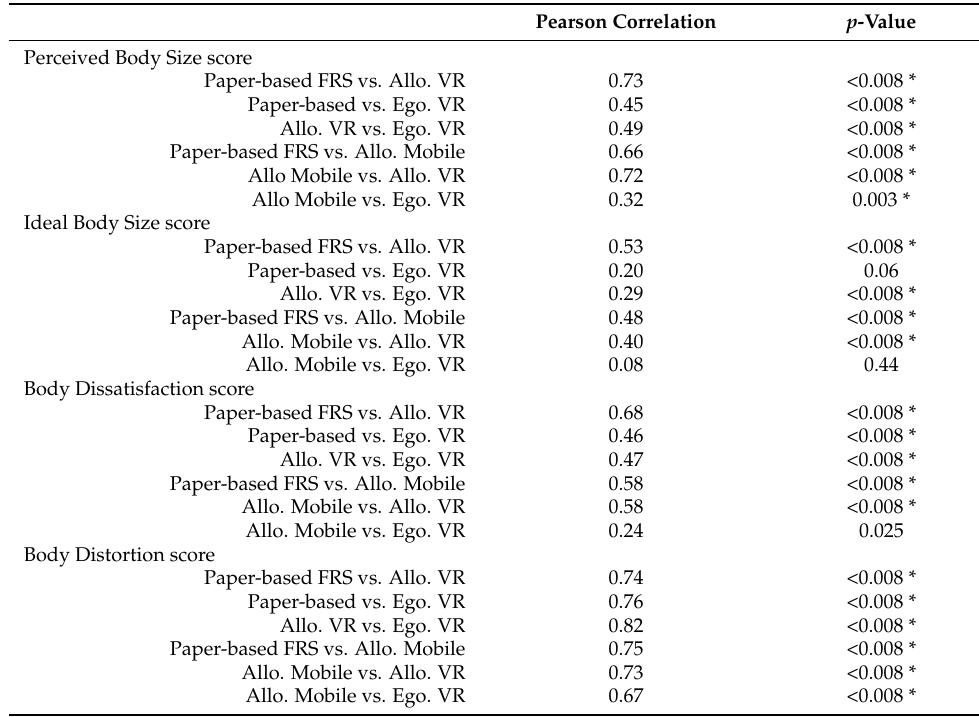
Table 2. Convergent and discriminant validity in adolescents, assessed by Pearson correlations for each component of BIDs between the allocentric perspective (paper, virtual reality, mobile application) and egocentric perspective (virtual reality by the e LoriCorps-IBRS 1.1) assessments. Pearson Correlation p -Value Perceived Body Size score Paper-based FRS vs. Allo. VR